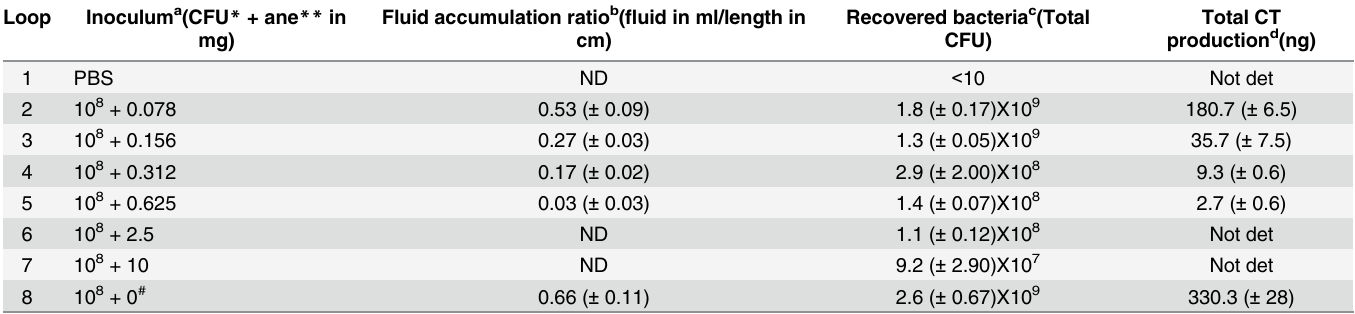
Table 3. Effects of anethole on fluid accumulation, CT production and V . cholerae (CRC41) viability in rabbit ileal